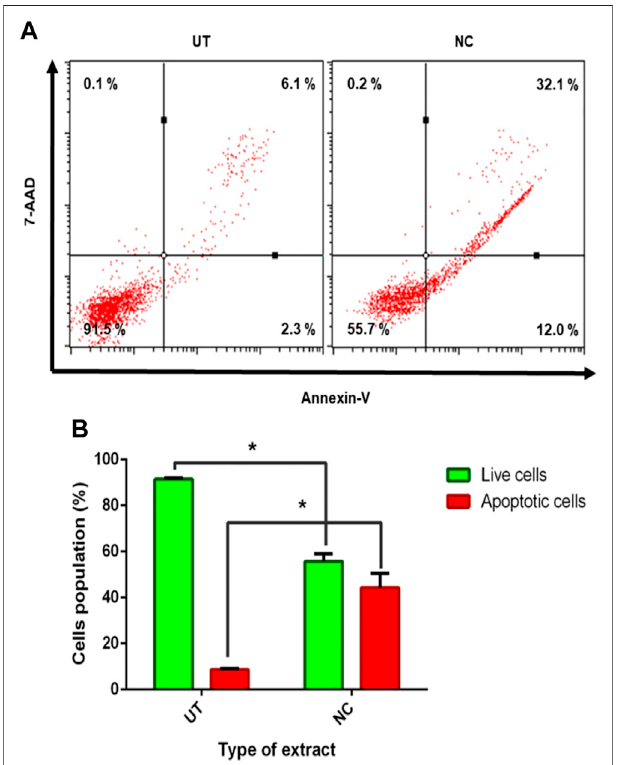
FIGURE 3 | Effect of NC leaves 80% ethanol extract on MCF-7 cells. (A) Representation of dot plot distribution of cells in living, death, and early and late apoptosis quadrants of MCF-7 cells treated with NC leaves 80% ethanol extractat72 hwithUTascontrol( n (cid:2) 3). (B) Theproportionpercentages of apoptotic (early and late apoptosis) and live cells are presented as percentage mean ± SD ( n (cid:2) 3). * indicates p < 0.05 concerning untreated.